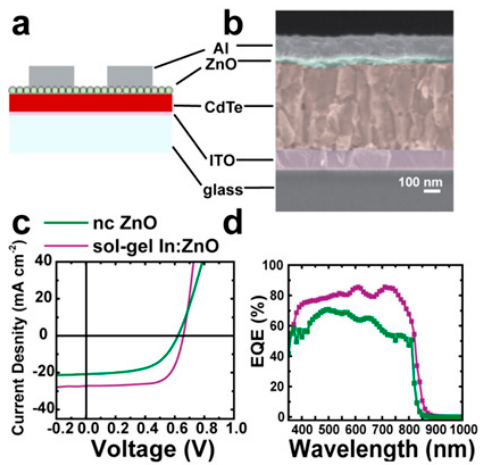
Figure 6. Schematic ( a ) and cross ‐ sectional SEM ( b ) of a superstrate style device with the following structure: glass/ITO/CdTe/ZnO/Al (false color added for clarity). J ‐ V characteristics ( c ) and external quantum efficiency ( d ) of devices prepared with colloidal nanocrystal ‐ based ZnO (green) and sol ‐ gel In ‐ doped ZnO (In:ZnO; purple). Reproduced with permission from [40]. Copyright 2014, American Chemical Society.